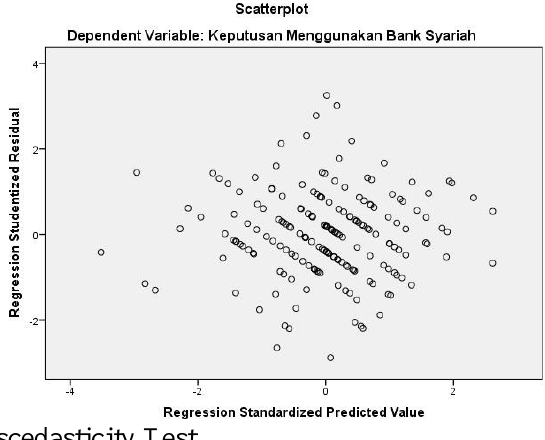
Figure 2. Heteroscedasticity Test